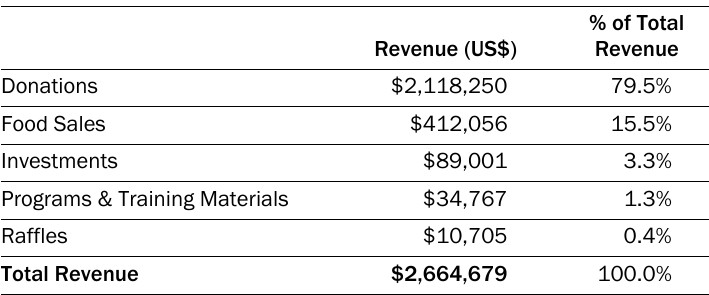
Table 2. The Food Project’s Total Revenue (in US$), FY2014